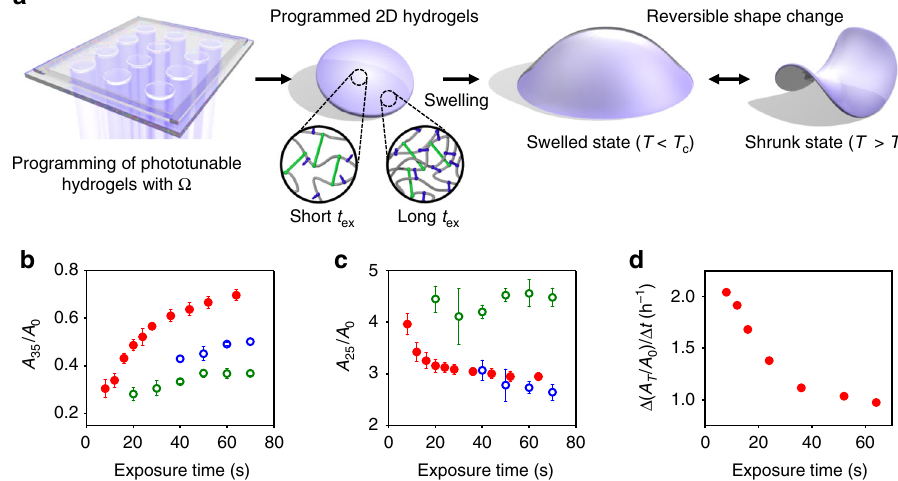
Fig. 1 Programming of phototunable hydrogels to create 3D structures. a Digital light 4D printing process. The hydrogels are encoded with a growth function (or target metric) Ω using digital light projection grayscale lithography. The created 3D structures undergo a reversible shape transition at volume phase transition temperature T c (~32.5 °C). T is temperature. The insets illustrate the polymer networks of the hydrogels at the early (short light exposure time t ex ) and late (long t ex ) stages of photopolymerization, where gray, blue, and green structures represent pNIPAm, BIS, and PEGDA, respectively. b , c Areal shrinking ( b ) and swelling ( c ) ratios of dual- (red circles), BIS- (blue open circles), and PEGDA (green open circles)-crosslinked pNIPAm hydrogels as a function of t ex . A 35 and A 25 are the areas of hydrogels at 25 °C and 35 °C, respectively. A 0 is the area of as-prepared hydrogels. Error bars: s. d. of three independent measurements. d Areal swelling rates Δ ( A T / A 0 )/ Δ t of dual-crosslinked pNIPAm hydrogels as a function of t ex . A T is the area of hydrogels. t is